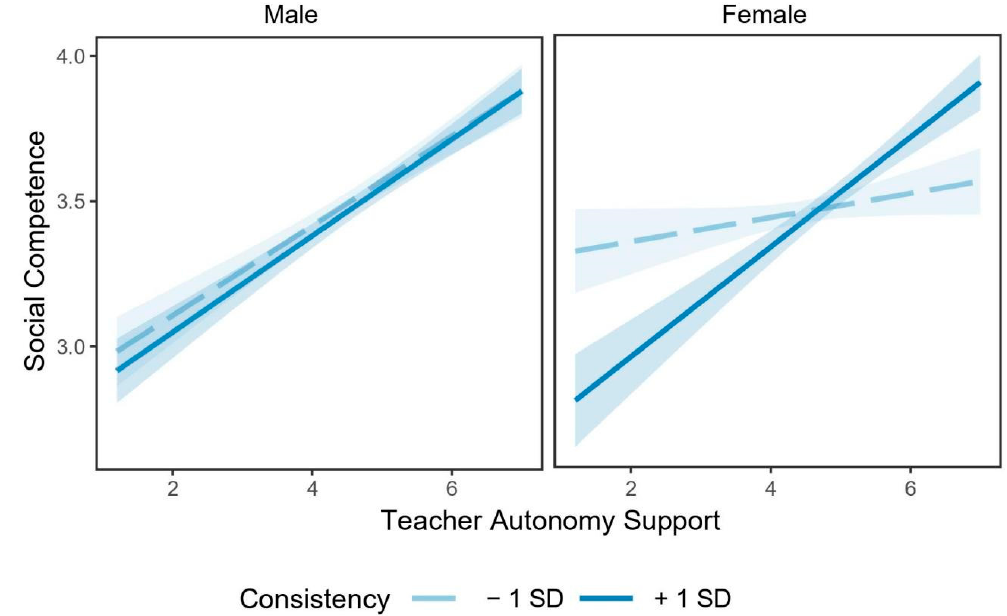
Figure 2. Interaction effect of teacher autonomy support, consistency, and students’ gender on social competence. Note: N = 1009. Consistency was divided into two levels based on mean: low = Mean − 1 SD , high = Mean + 1 SD .